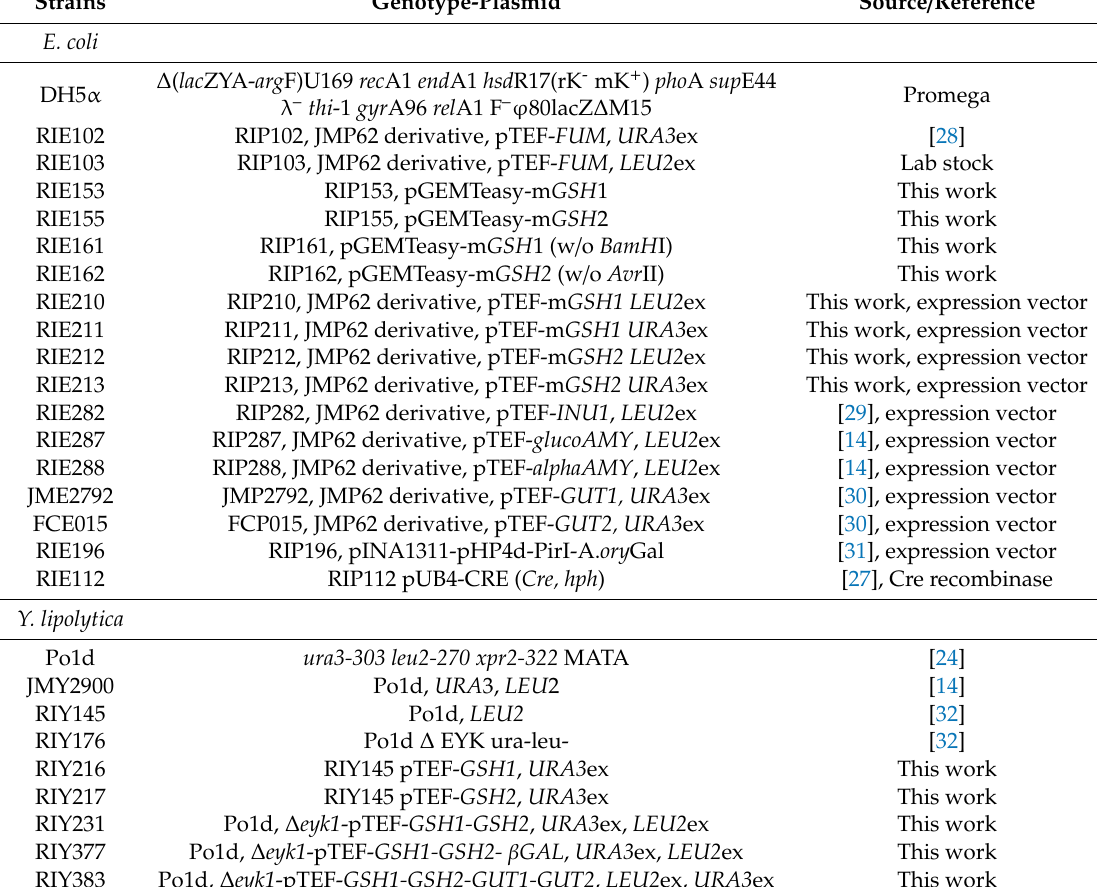
Table 1. Plasmids and Y. lipolytica used in this